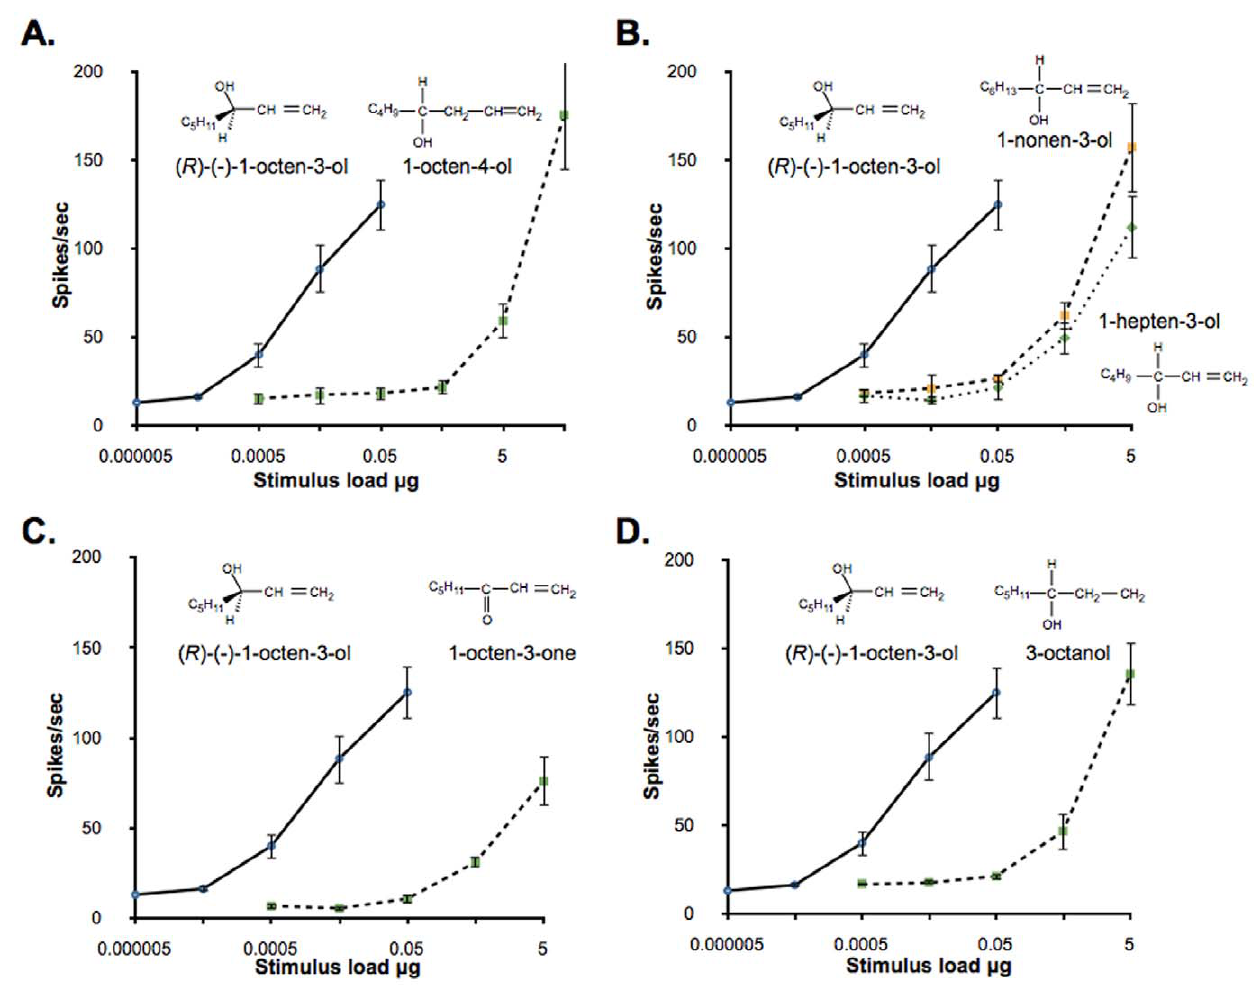
Figure 2. ( R )-( 2 )-1-octen-3-ol strongly preferred over related analogs. Dose-response relationships from the ‘‘C’’ neuron in maxillary palp sensilla of female Ae. aegypti in response to increasing doses of ( R )-( 2 )-1-octen-3-ol (n=5) and structurally similar chemicals. (A) Movement of chiral center from ‘‘3’’ to ‘‘4’’ position, 1-octen-4-ol (n=4). (B) Changes in carbon chain length: 1-hepten-3-ol (n=4) and 1-nonen-3-ol (n=3). (C) Change in functional group with loss of chiral center, 1-octen-3-one (n=4). (D) Saturation of double bond, 3-octanol (n=4). Points represented are mean 6 SEM.